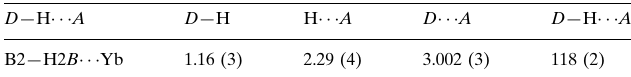
Hydrogen-bond geometry (A˚ , (cid:2)